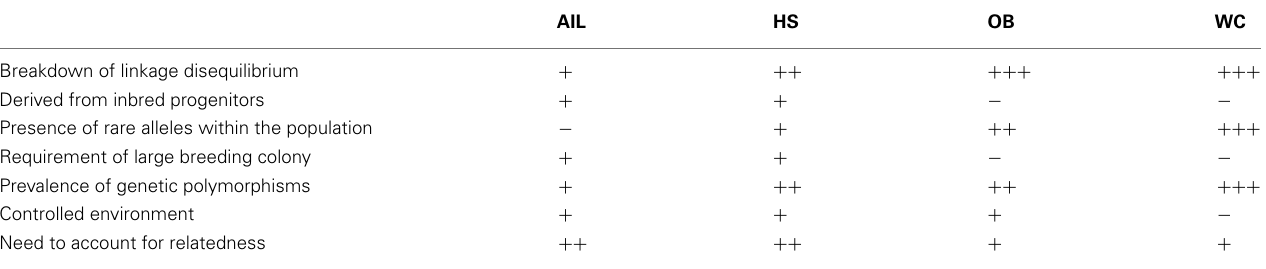
Table 1 | Comparison chart scoring advanced intercross lines (AIL), heterogeneous stock (HS), outbred (OB), and wild-caught (WC) mice on seven variables researchers may consider before choosing a population to